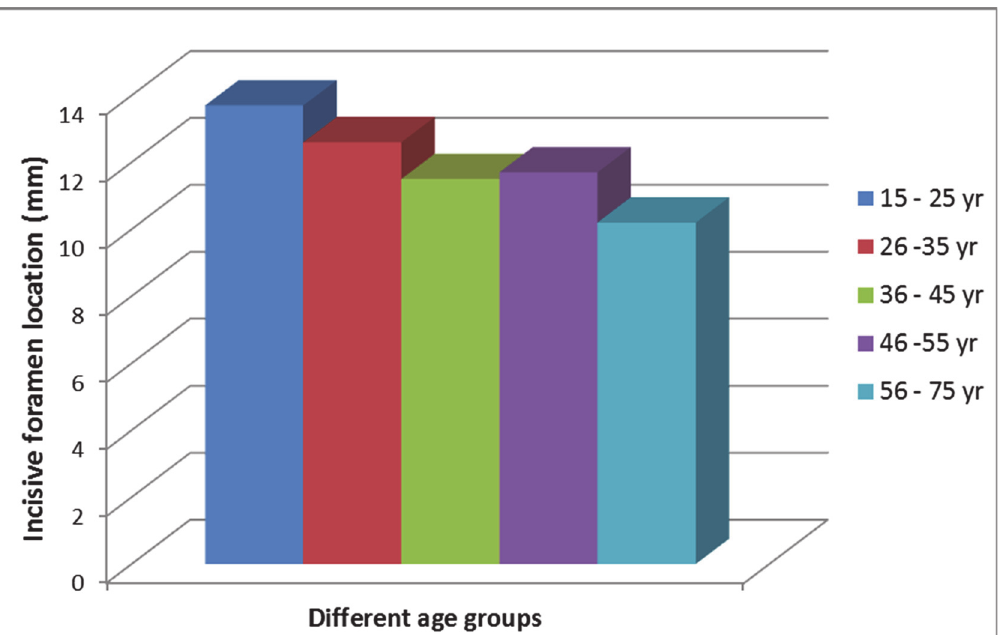
Fig 6. Differences in the distance from the incisive foramen to the most anteroinferior point of the cortical plate of labial bone in subjects of different age